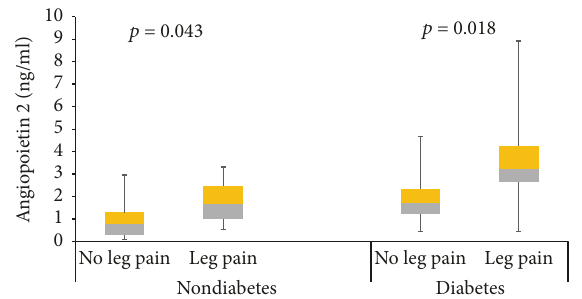
Figure 1: Circulating levels of angiopoietin 1 among patients with leg pains based on their diabetes status. Data presented as median interquartile range and analysed with Mann–Whitney test.